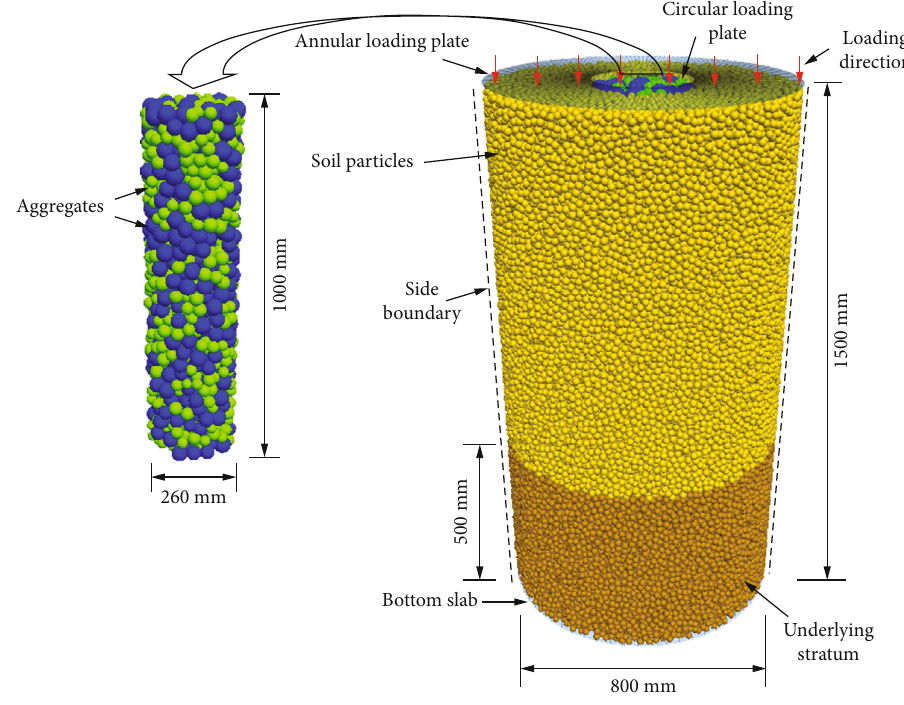
Figure 2: 3D model for unit cell of a fl oating stone column in soft clay.